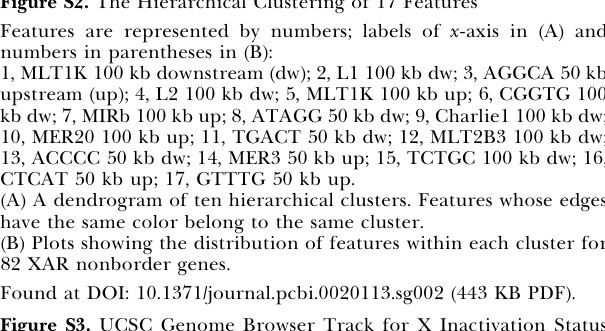
Figure S1. Recursive Feature Reduction on All XAR Nonborder Genes The top plot represents the CV rate on XAR nonborder genes for each set of features. The bottom plot represents the prediction rate for XCR genes using SVM models constructed from XAR nonborder genes. At 17 features, both CV and prediction rates reach their respective maximum values. Figure S2. The Hierarchical Clustering of 17 Features Features are represented by numbers; labels of x -axis in (A) and numbers in parentheses in (B): 1, MLT1K 100 kb downstream (dw); 2, L1 100 kb dw; 3, AGGCA 50 kb upstream (up); 4, L2 100 kb dw; 5, MLT1K 100 kb up; 6, CGGTG 100 kb dw; 7, MIRb 100 kb up; 8, ATAGG 50 kb dw; 9, Charlie1 100 kb dw; 10, MER20 100 kb up; 11, TGACT 50 kb dw; 12, MLT2B3 100 kb dw; 13, ACCCC 50 kb dw; 14, MER3 50 kb up; 15, TCTGC 100 kb dw; 16, CTCAT 50 kb up; 17, GTTTG 50 kb up. (A) A dendrogram of ten hierarchical clusters. Features whose edges have the same color belong to the same cluster. (B) Plots showing the distribution of features within each cluster for 82 XAR nonborder genes. Figure S3. UCSC Genome Browser Track for X Inactivation Status and Prediction of All X-Linked Genes Genes and ESTs are denoted by solid brown bars. The color intensity reflects the propensity for escaping inactivation, with the darkest brown indicating those that escape in all experiments (based on somatic cell hybrid data in [12]). Detailed information about the number of hybrids tested and results from SVM predictions can be seen by clicking on individual elements in this track. Found at DOI: 10.1371/journal.pcbi.0020113.sg003 (23 KB PDF). Table S1. Sequence Features Found To Be Statistically Different between Escaping and Subject Genes for Whole X Chromosome (ALL, q , 0.05), XAR ( q , 0.05), and Stratum 3 (S3, q , 0.2), Respectively Table S2. Subset of Sequence Features Found To Be Statistically Different between Escaping and Subject Genes Commonly in Each of the Whole X Chromosome (ALL), XAR, and Stratum 3 (S3) Table S3. CV and Prediction Rates for SVM Classification Experi- ments Using 100 Sets of Genes Randomly Drawn from XAR Nonborder Genes Table S4. Frequently Selected Features during 100 Independent Feature Selection Experiments Involving Random Subsets of XAR Nonborder Genes Table S5. Leave-One-Out CV rates for XAR Nonborder Genes and Prediction Accuracy for XCR Genes of SVM Classifiers during Recursive Feature Selection Table S6. The Predicted X Inactivation Status of All X-Linked Genes along with the Associated Probability of Prediction as Determined by a SVM Classifier Constructed Using a Reduced Set of 12 Sequence Features Found at DOI: 10.1371/journal.pcbi.0020113.st006 (86 KB